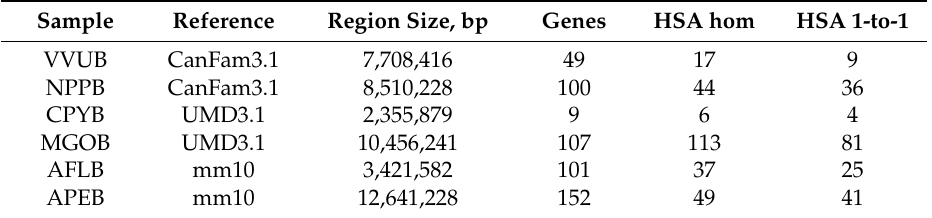
B chromosome genes statistics. Genes retrieved from the Ensembl 92 database. HSA hom—number of genes with homologs in human ( Homo sapiens L.), HSA 1-to-1—number of genes with one-to-one (i.e., single copy) orthologs in